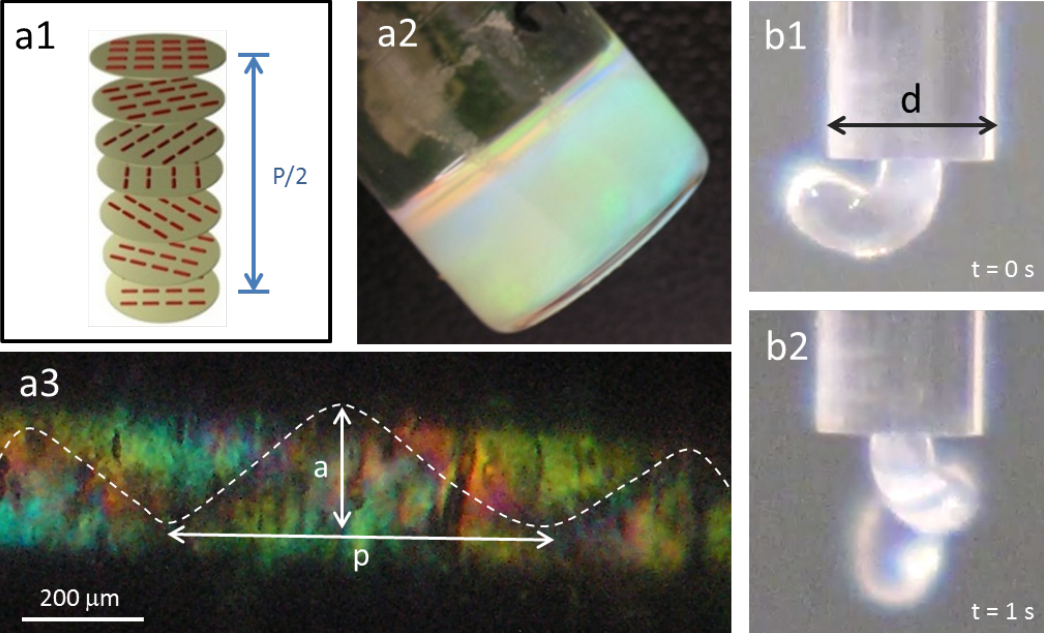
Figure 2. Cholesteric liquid crystalline phases in cellulosic solutions: ( a1 ) schematic of the cholesteric structure; ( a2 ) cholesteric hydroxypropyl cellulose (HPC) solution; ( b1 ) and ( b2 ) show HPC a2 solution when exiting a capillary tube, d = 1.7 mm; ( a3 )